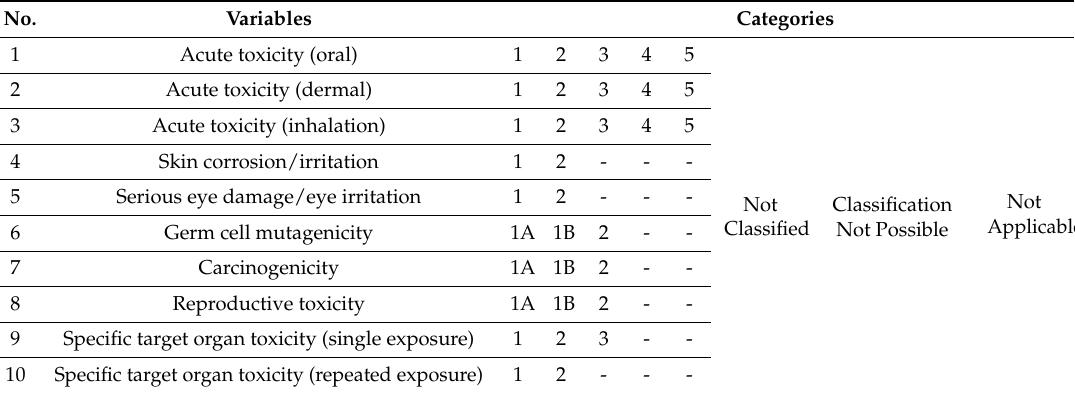
Table 1. Types of health hazard variables according to the Globally Harmonized System.